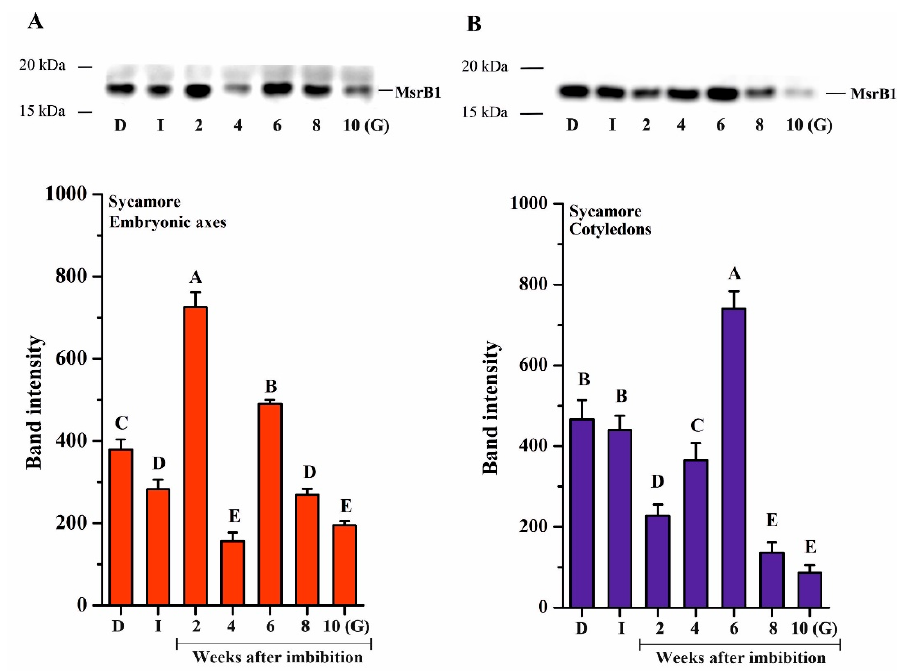
Figure 5. Western blot analysis and densitometry analysis of methionine sulfoxide reductase (Msr)B1 protein in the embryonic axes ( A ) and cotyledons ( B ) of dry and germinating sycamore seeds. Abbreviations: D, Dry seeds; I, Imbibed seeds; G, Germinated seeds. The data are the means of three independent replicates ± the STDs. The same letters indicate groups that were not significantly different according to Tukey’s test.